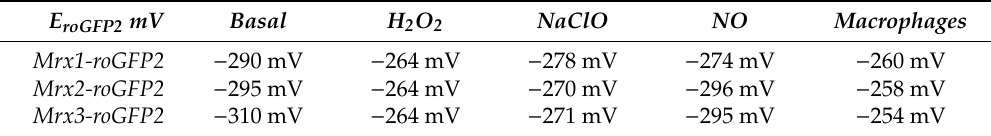
Table 1. E roGFP2 (in millivolts, mV) calculated for each mycoredoxin fused to reduction-oxidation sensitive green fluorescent protein (roGFP2) in the absence of oxidant stressors (basal), in response to 5 mM H 2 O 2 , 5 mM NaClO, or 5 mM DETA NONOate (NO), and during macrophage infection, representing the most oxidized E roGFP2 of the sensor fused to each Mrx-roGFP2. E roGFP2 mV Basal H 2 O 2 NaClO NO Macrophages Mrx1-roGFP2 − 290 mV − 264 mV − 278 mV